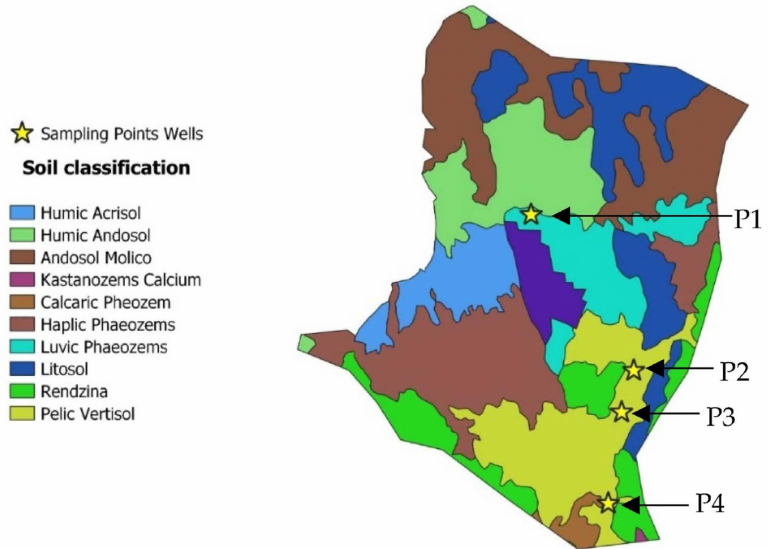
Figure 4. Soil classification of the Cuernavaca aquifer.